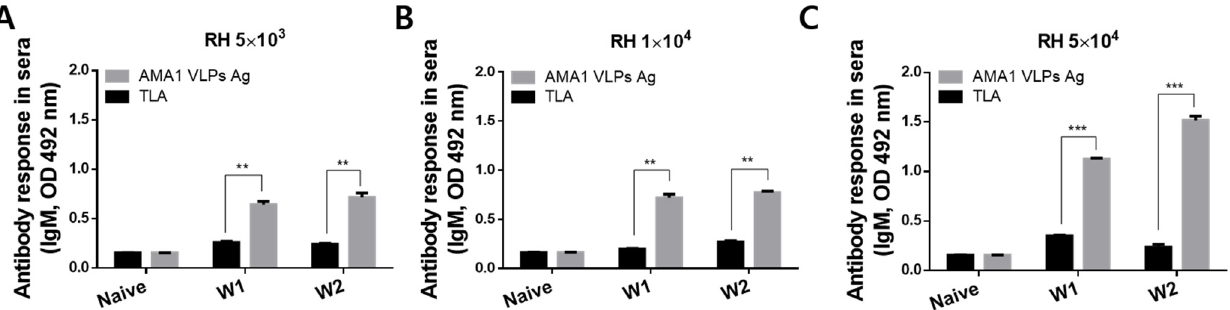
Figure 5. Reactivity of T. gondii RH infection-induced IgM antibody to AMA1 VLPs antigen. After orally administering 5 × 10 3 ( A ), 1 × 10 4 ( B ), or 5 × 10 4 ( C ) doses of T. gondii RH tachyzoites, sera were collected at 1 and 2 wpi to evaluate T. gondii -specific IgM antibody responses. ELISA was performed using coated TLA or AMA1 VLPs as antigens. Data are presented as mean ± SD and are representative of the 3 individual experiments performed in triplicate (** p < 0.01, *** p < 0.001 vs. TLA).